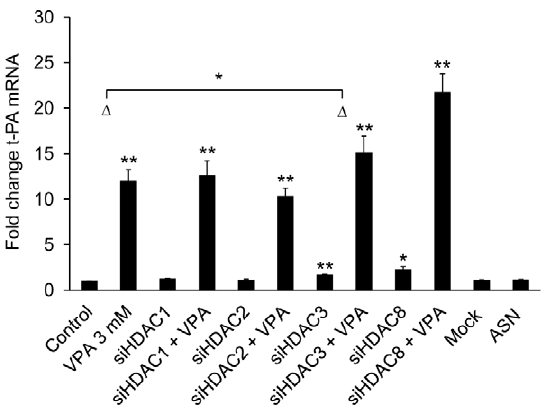
Figure 4. siRNA mediated knock-down of class I HDACs. t-PA mRNA expression in HUVECs treated with class I HDAC-targeting siRNAs for 72 h and then stimulated with 3 mM VPA for 24 h. Mock indicate cells treated with DharmaFECT 4 transfection reagent alone and ASN indicate cells transfected with All Star Negative control siRNA (Qiagen). Unless indicated in the figure, statistical comparisons are made relative to untreated control cells. *p , 0.05, **p , 0.01. The results are presented as mean values 6 SEM of four independent experiments performed in duplicate.